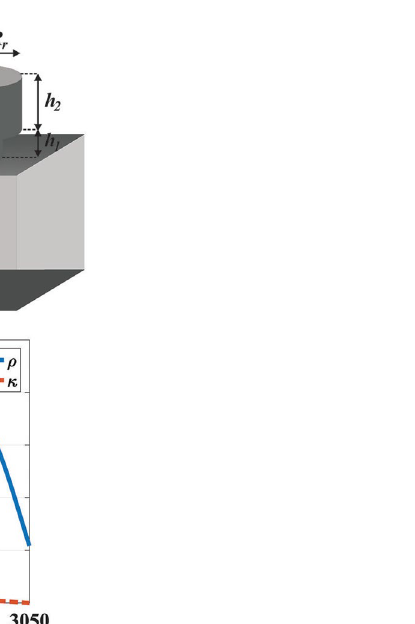
Figure 7. The behavior of the realized ANM under the incidence of an acoustic plane wave. The incident plane wave on the input boundary is perfectly transmitted to the output interface without distortion.